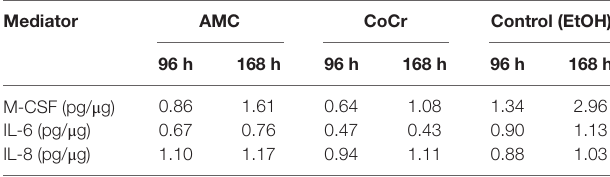
TaBle 2 | Protein concentration in conditioned